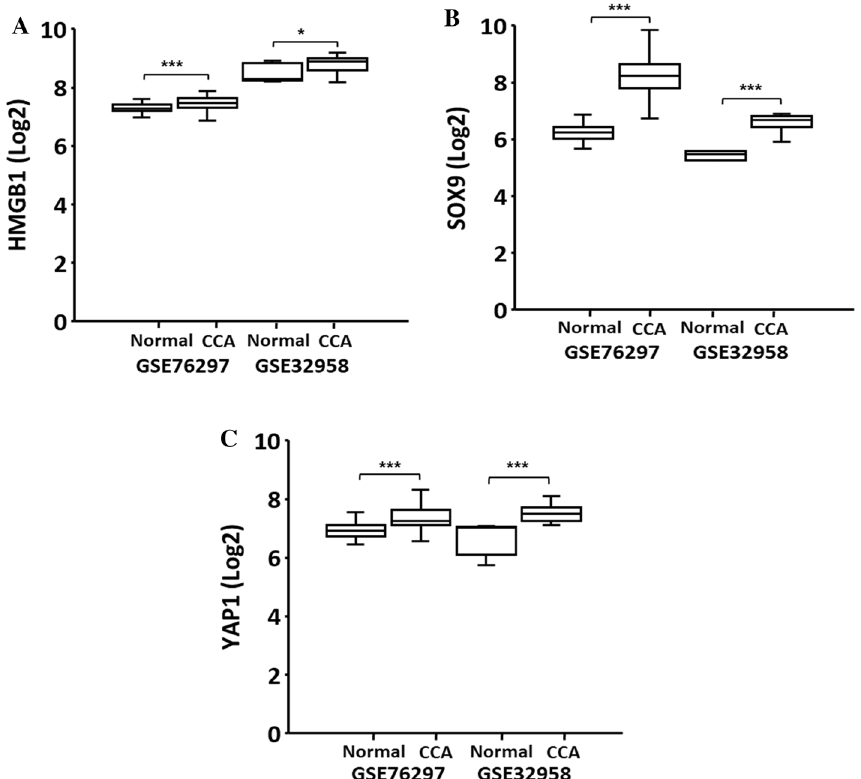
Fig. 1 The data of open- access database analysis tools including Gene Expression Omnibus (GEO) dataset ( A – C ). The GSE76297; normal tissues (n = 93) and cholangiocar- cinoma (CCA) (n = 92), the GSE32958; normal tissues (n = 7) and CCA (n =